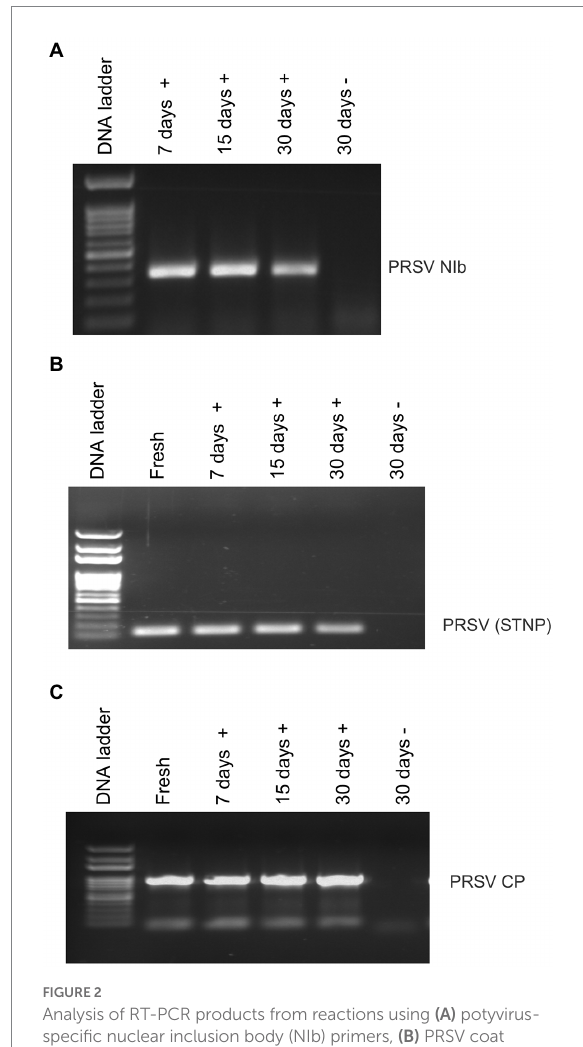
FIGURE 2 Analysis of RT-PCR products from reactions using (A) potyvirus- specific nuclear inclusion body (NIb) primers, (B) PRSV coat protein (CP) primers or (C) PRSV-specific single-tube nested PCR (STNP) and total RNA from symptomatic (+) or asymptomatic ( − ) fresh papaya leaves or leaves stored in RNA later ® for various periods.